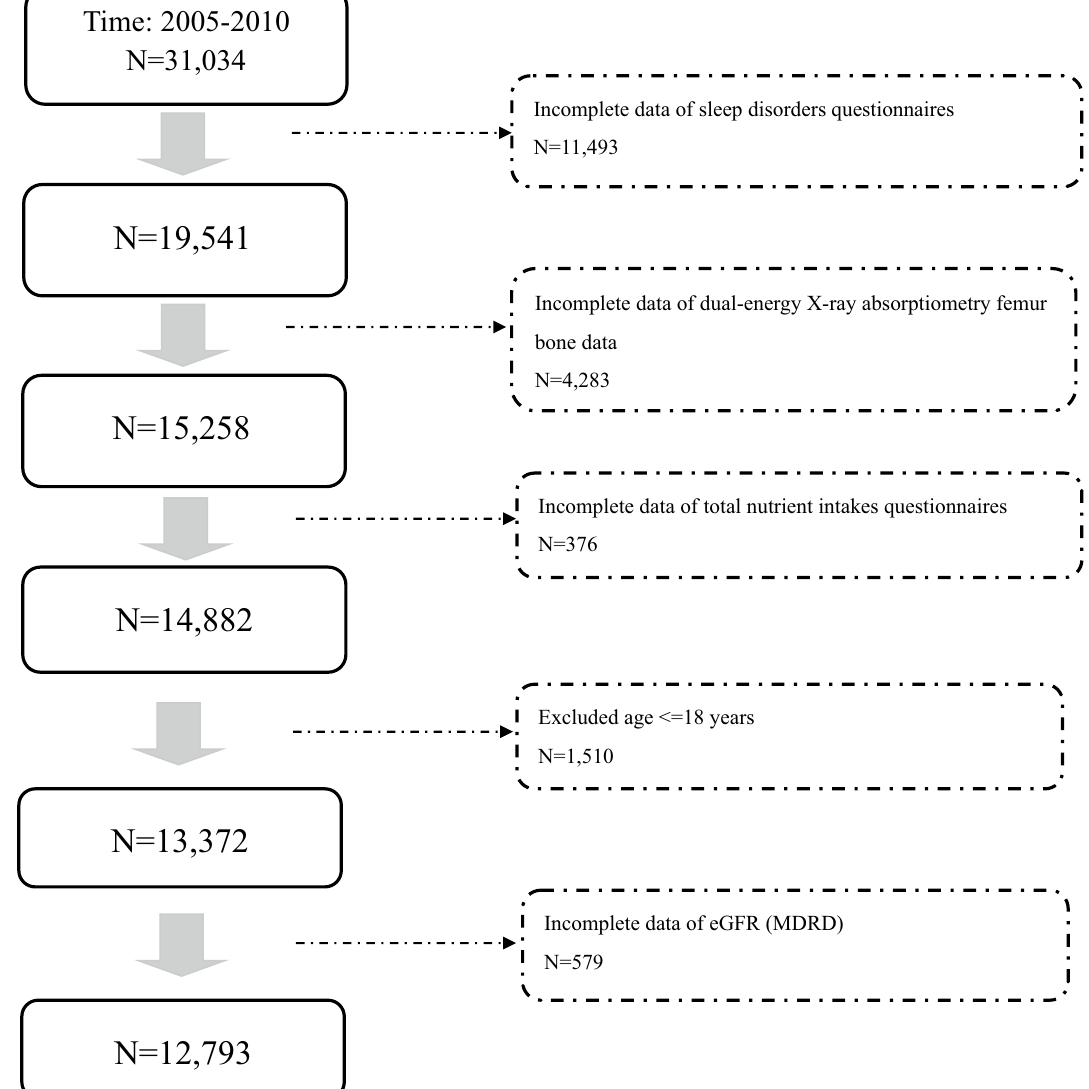
Figure 1. The selection process of subjects from the 2005–2010 NHANES